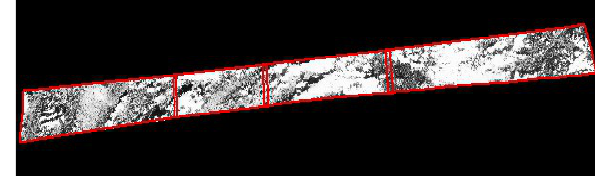
Figure 6. Subset 1-4 mosaicking of DS1105-2264DF039